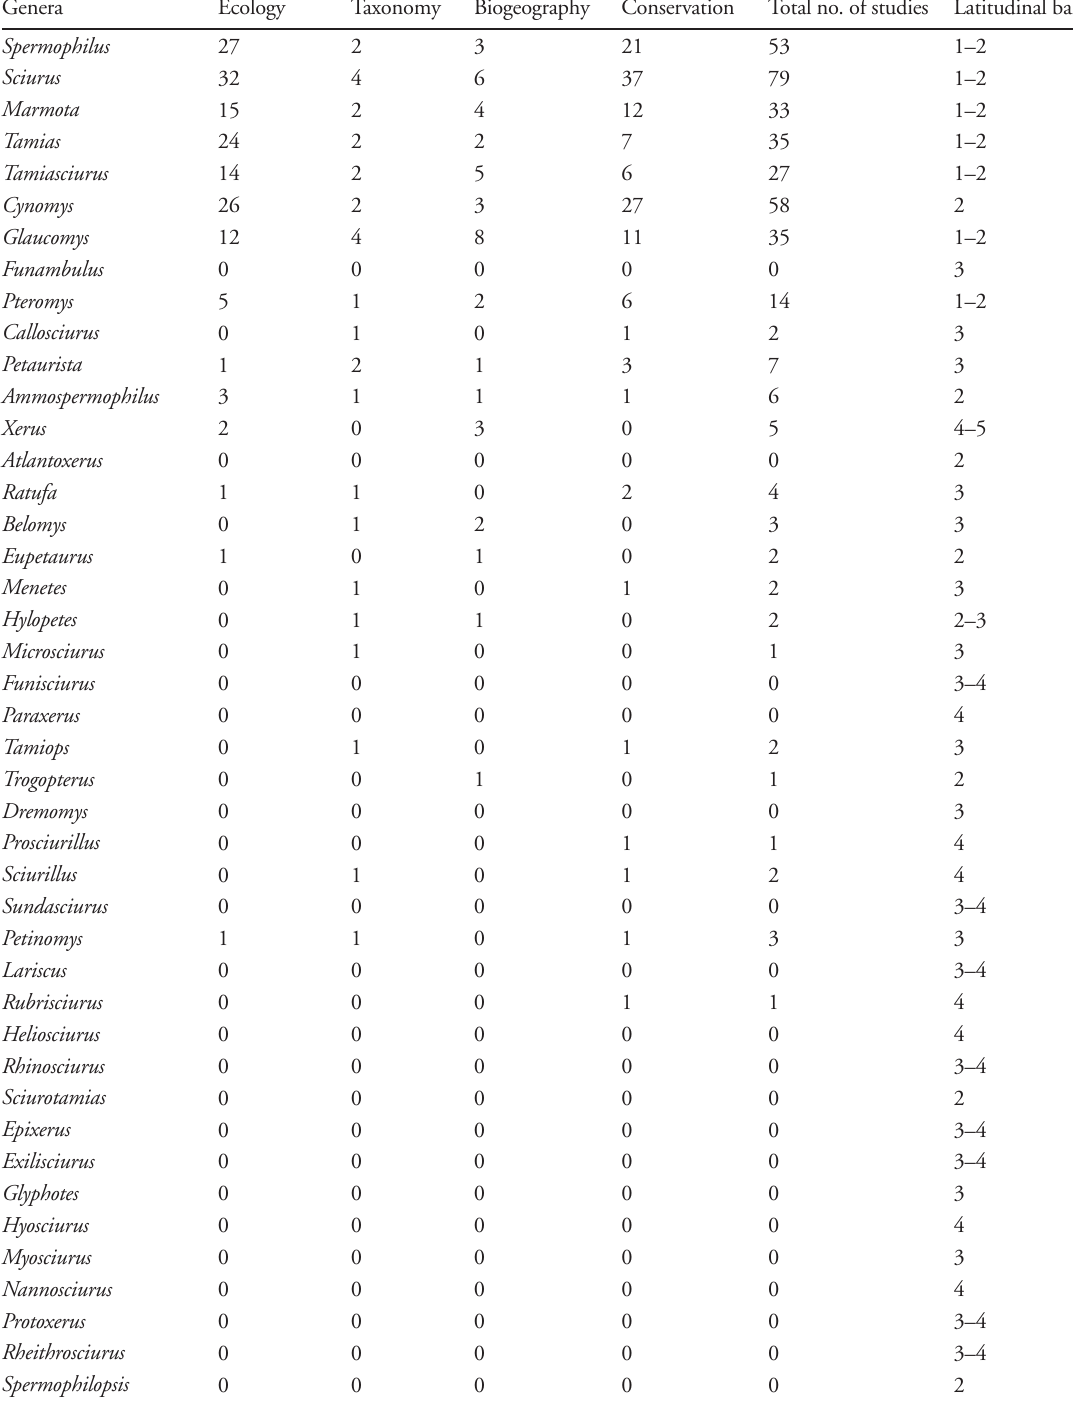
Table 1. Summary of the studies concerning the biology of Sciuridae genera obtained from ISI Web of Knowledge. Symbols for the latitudinal bands: band 1: from 71°N to 43°N, band 2: from 42°59´N to 20°N, band 3: from 19°59´N to 0°, and band 4: from 0° to 20°S. When more than one band is involved (i.e. 12, 23, etc), this means that the given genus occurs in both latitudinal bands. Genera